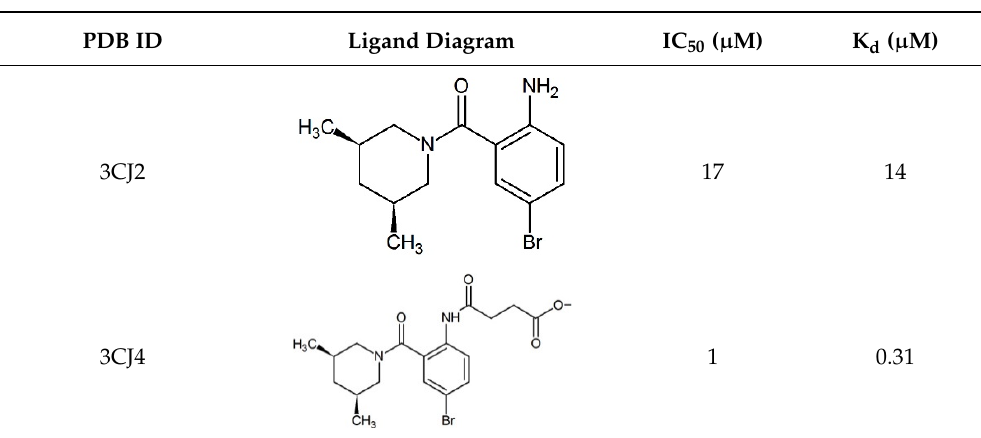
Table 1. Structures and affinity data for the drug candidates discovered by Antonysamy et al. used in this work. Inspection of the structures shows that one (3CJ2) is the scaffold for the creation of the other (3CJ4).